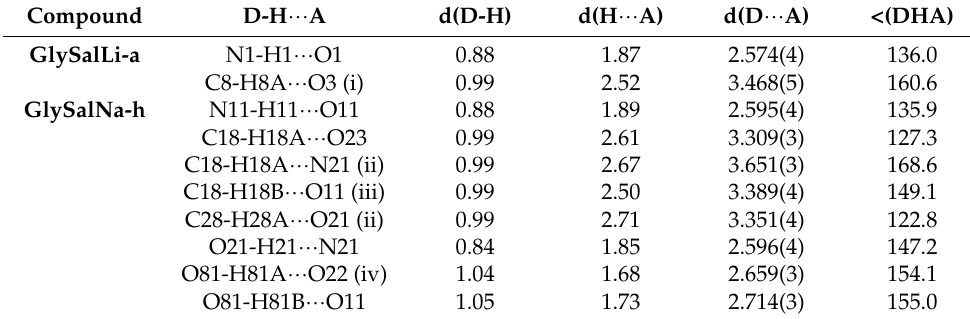
Table 3. Hydrogen bonds for GlySalLi-a and GlySalNa-h.